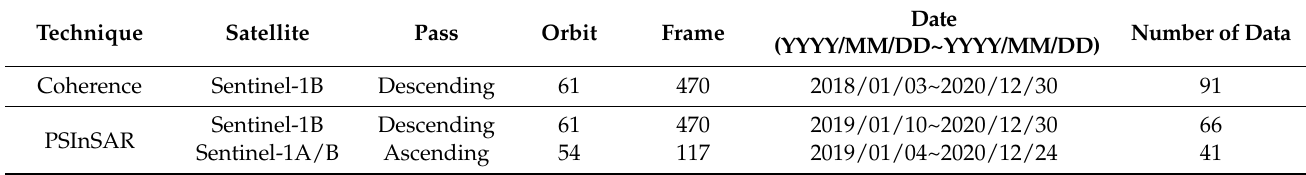
Table 1. Sentinel-1 SAR dataset used in this